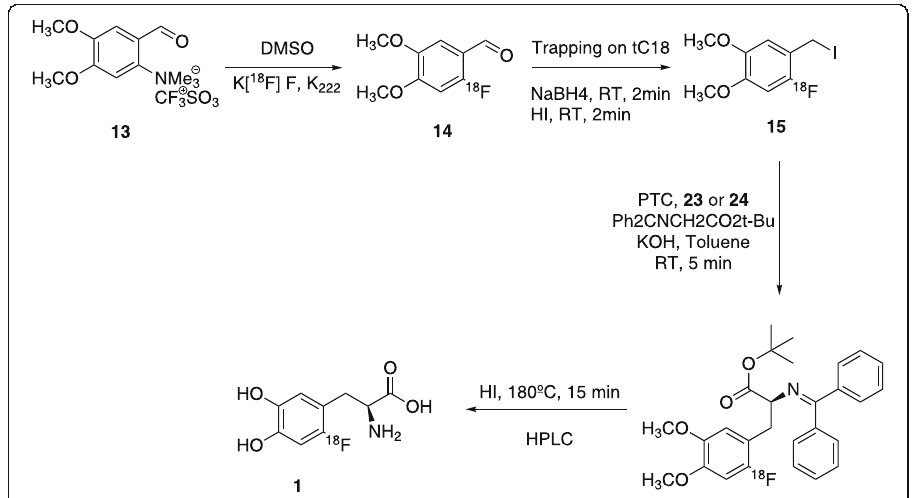
Fig. 8 Synthesis of 6-[ 18 F]FDOPA starting from trimethylammonium veratraldehyde triflate precursor,